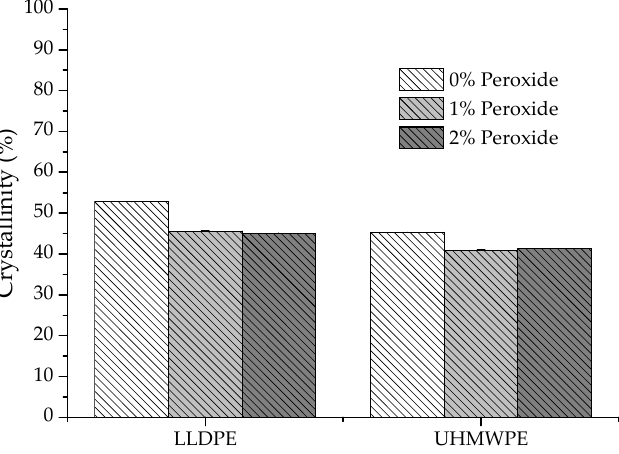
Figure 13. Variation in the degree of crystallinity of LLDPE and UHMWPE with 0%, 1% and 2% peroxide.